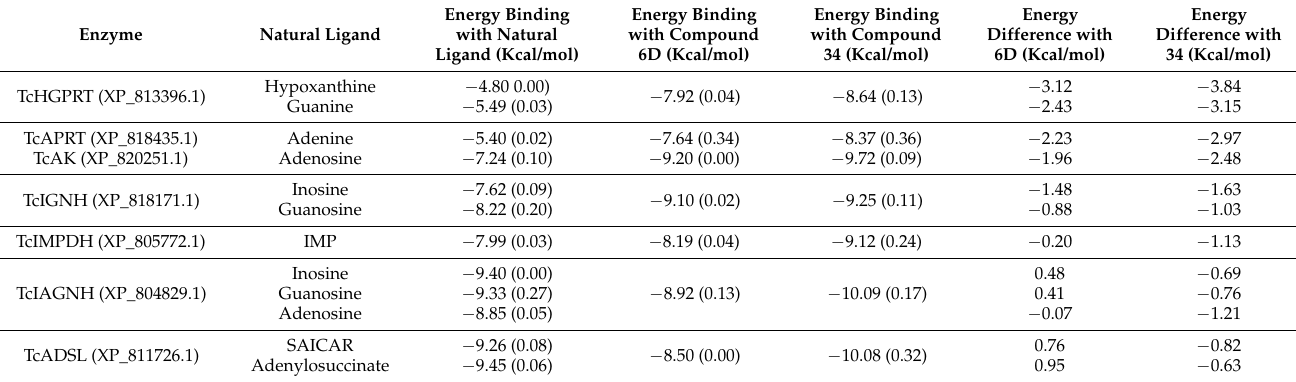
Table 4. Free binding energies of molecular docking between natural ligands and hit compounds with enzymes from the purine salvage pathway of T. cruzi CL